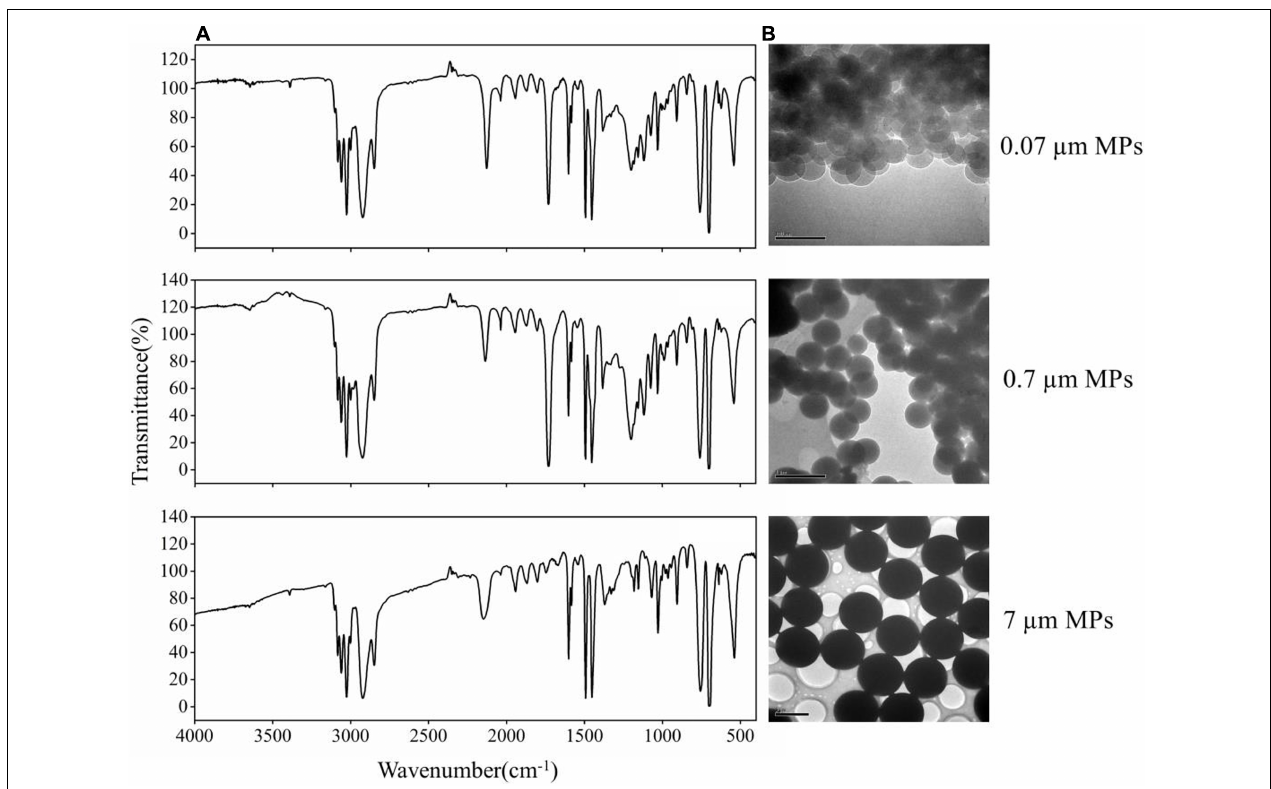
FIGURE 1 | (A) The FTIR spectra showed that three MPs powders (0.07, 0.7, and 7 µ m) were polystyrene. (B) The TEM images reveal the primary size and morphology of PS-MPs in culture